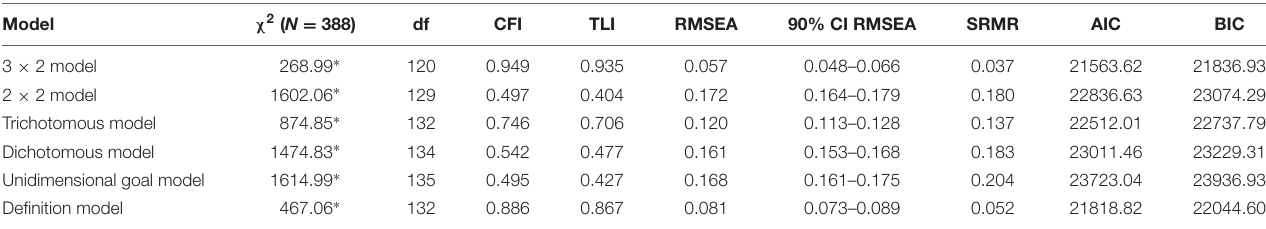
TABLE 3 | Comparison of the achievement goal conceptualizations. Model